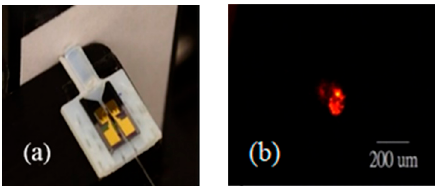
Figure 20. Pictures show ( a ) scanner coupled with optical fiber and GRIN lens. ( b ) direct observation of beam profile. Beam spot is the bright spot in the figure. Surround scattering red lights are from input fiber. Table 3. Light coupling measurements.